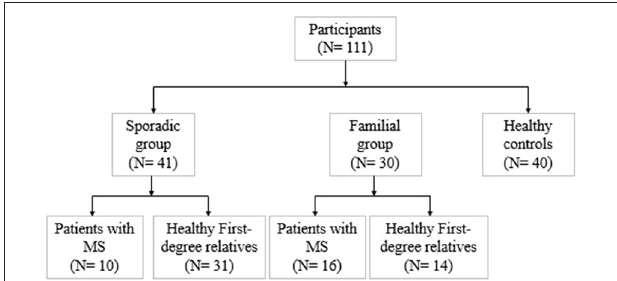
FIGURE 1 | The flow diagram of participants that were allocated to groups.